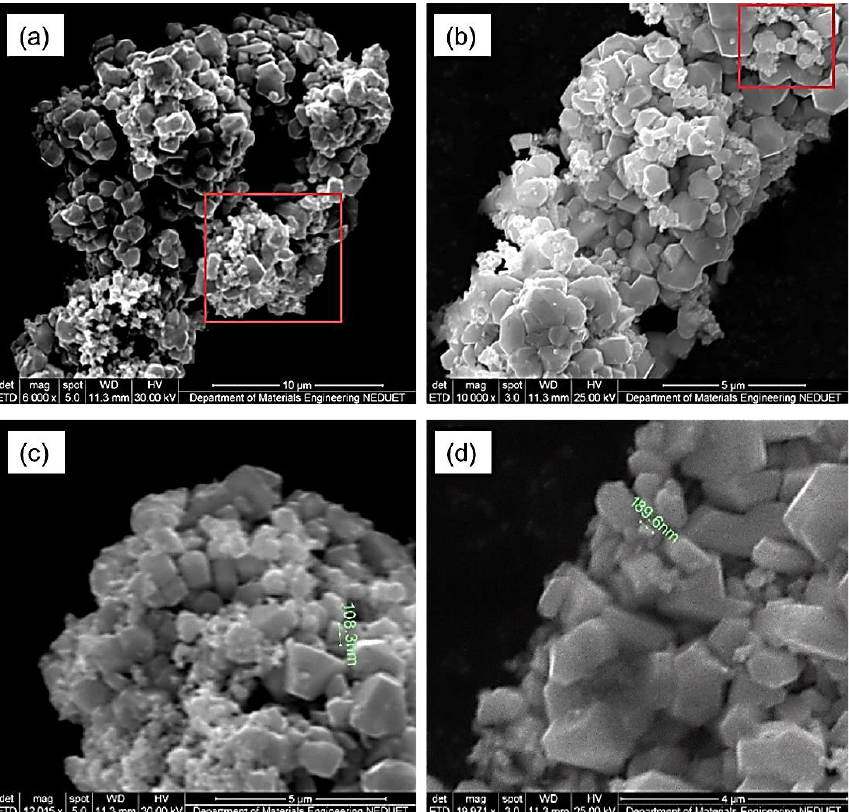
Figure 5. SEM images with different magnifications, where ( a ) 6000×, ( b ) 10,000×, ( c ) 12,015× and ( d ) 19,971× of the prepared Ag-NPs. The triangular shape of particles can be seen at different magnifi-